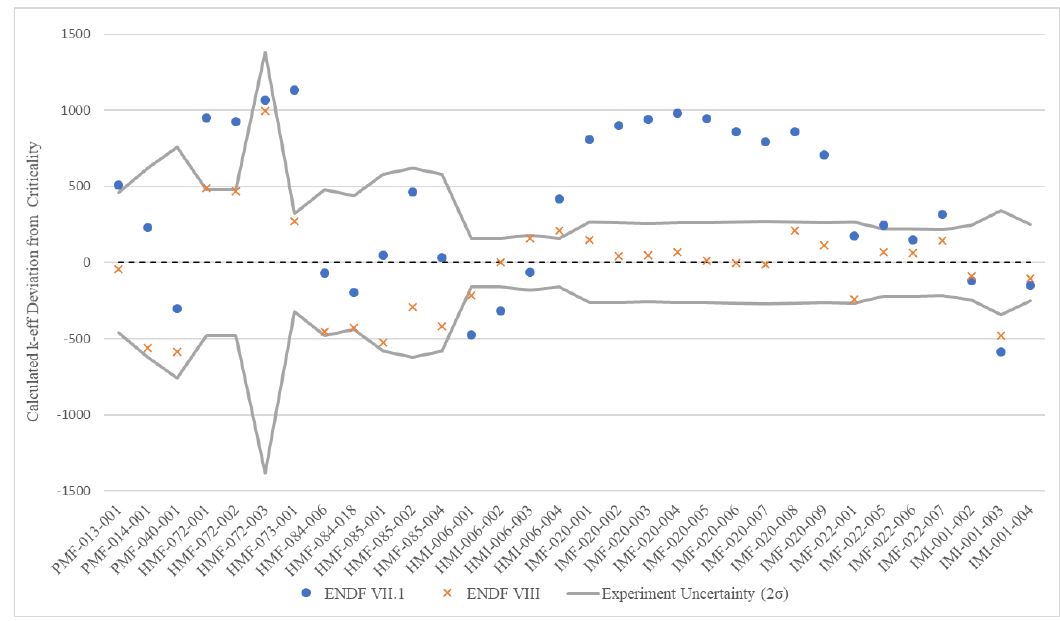
Figure 1. Change in C-E from ENDF-VII.1 to